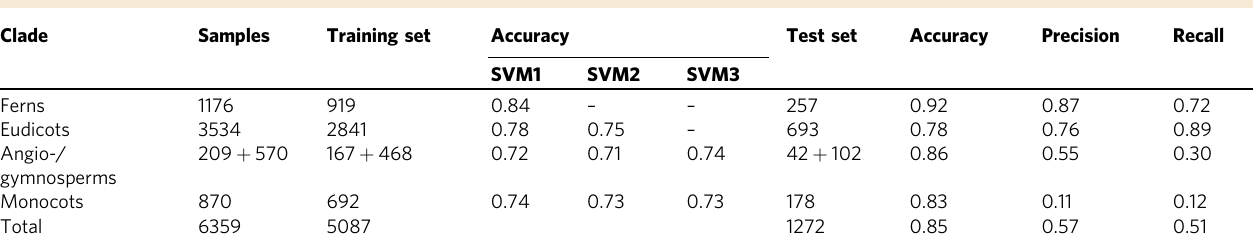
Table 2 Prediction of plant clades using nested SVMs. Clade Samples Training set Accuracy Test set Accuracy Precision Recall SVM1 SVM2 SVM3 Ferns